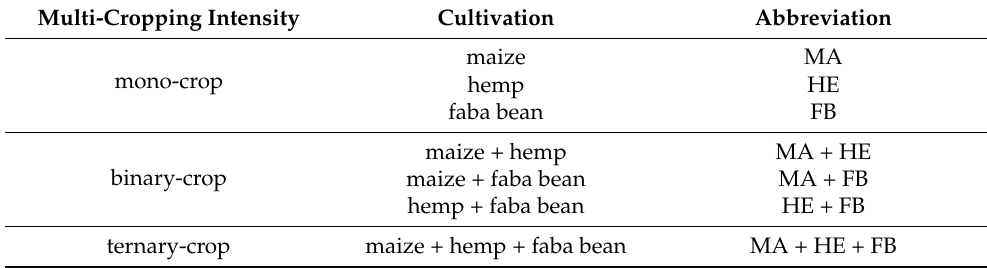
Table 1. Multi-cropping diversity.